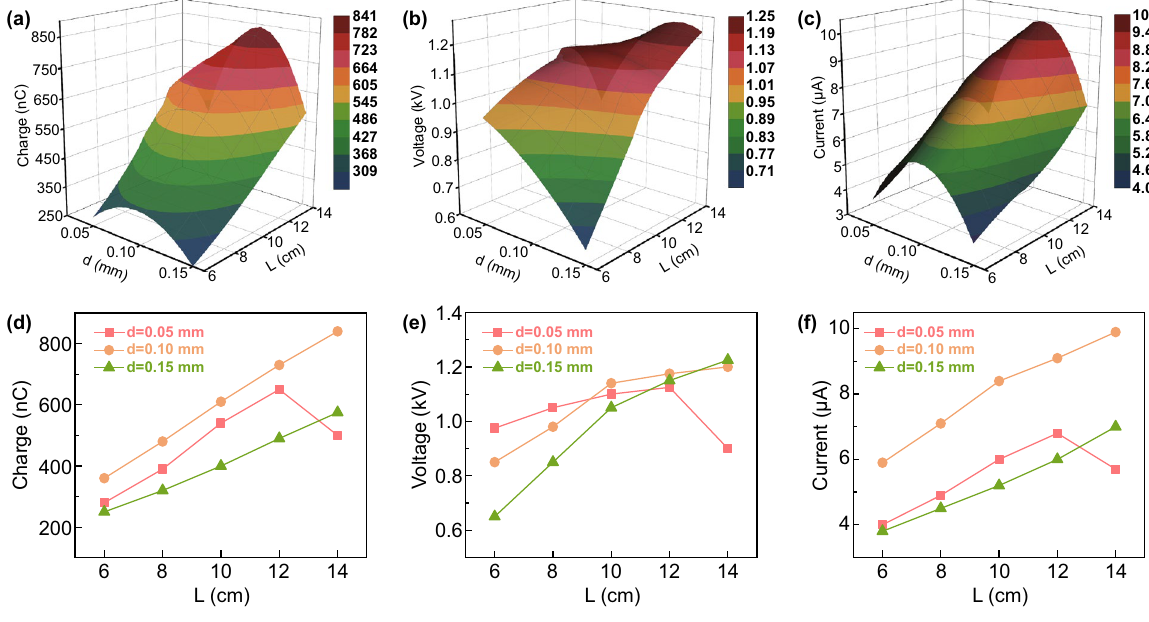
Fig. 3 W-HNG configuration optimization. 3D surface graphs of a Q sc , b V oc , and c I sc on changing both the thickness and length of the spring steel sheet and their corresponding 2D graphs ( d – f